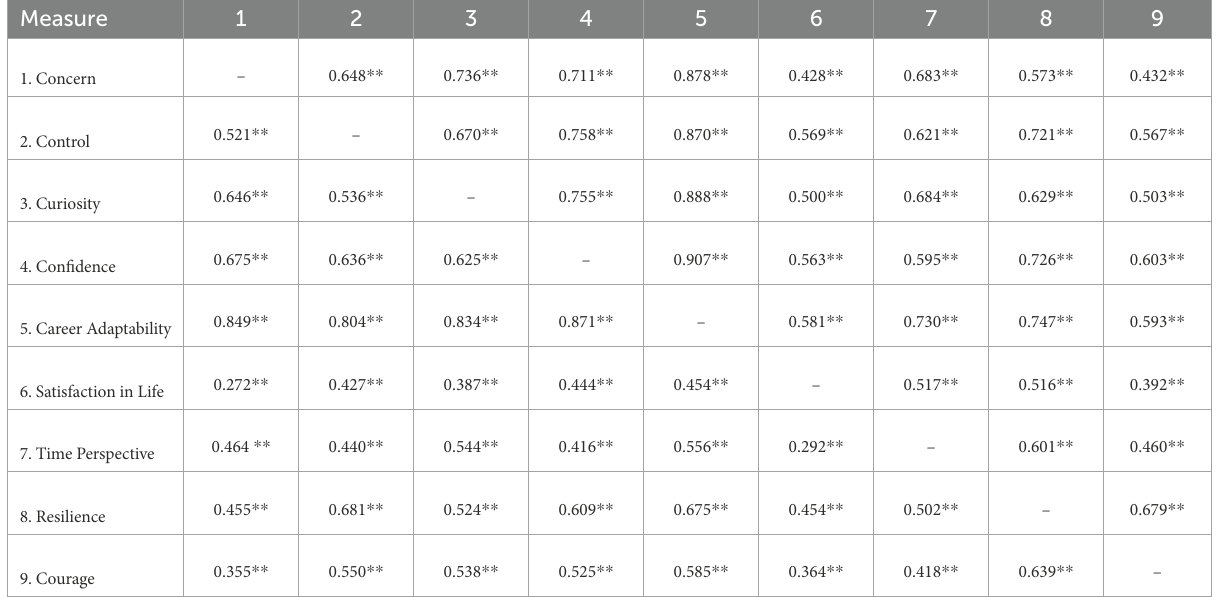
TABLE 1 Correlations among the study variables at pre- and